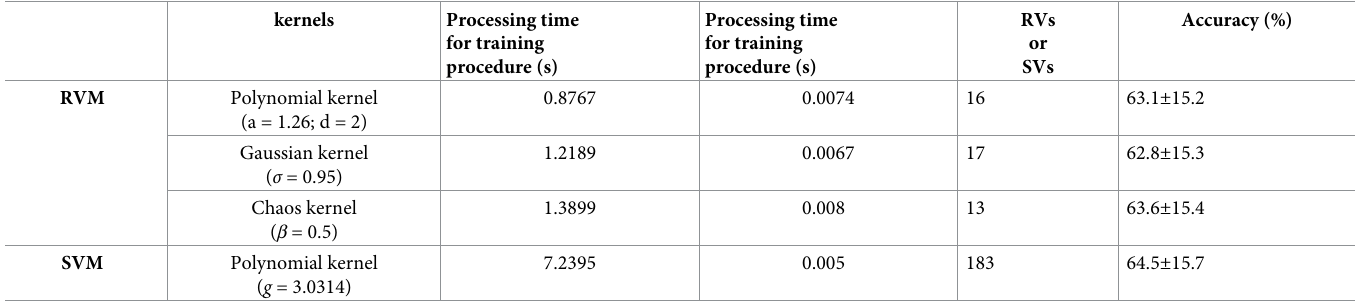
Table 3. Comprehensive comparison of RVMs based on three kernels and SVM. kernels Processing time for